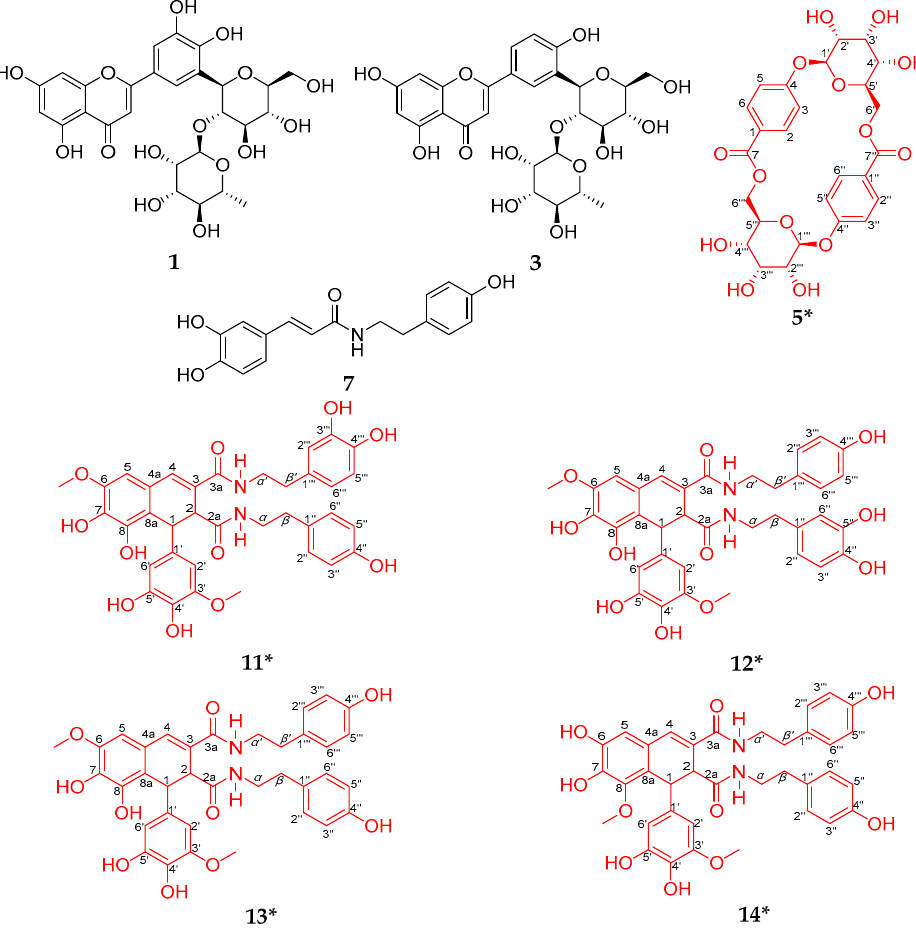
Figure 5. Compounds isolated and identified from WUE-A4. * New compounds; the red structures belong to new compounds.